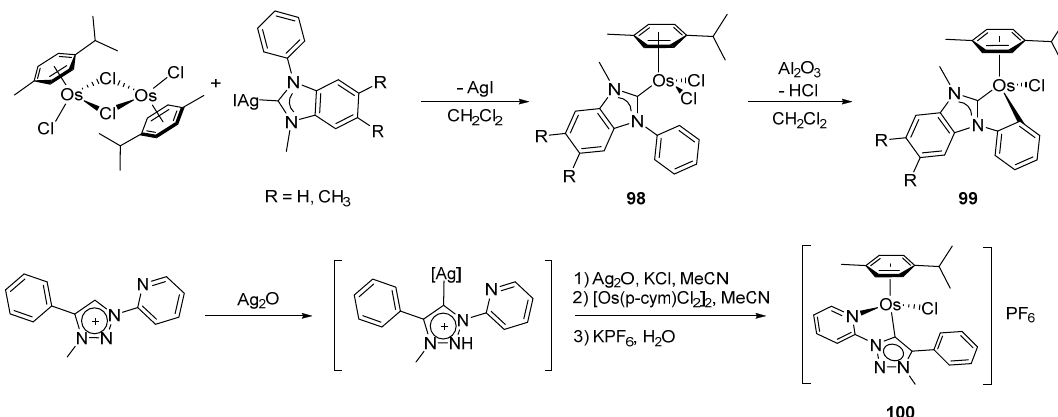
Figure 20. Synthesis of mono -cyclometalated complexes through transmetalation reactions with silver(I) derivatives.